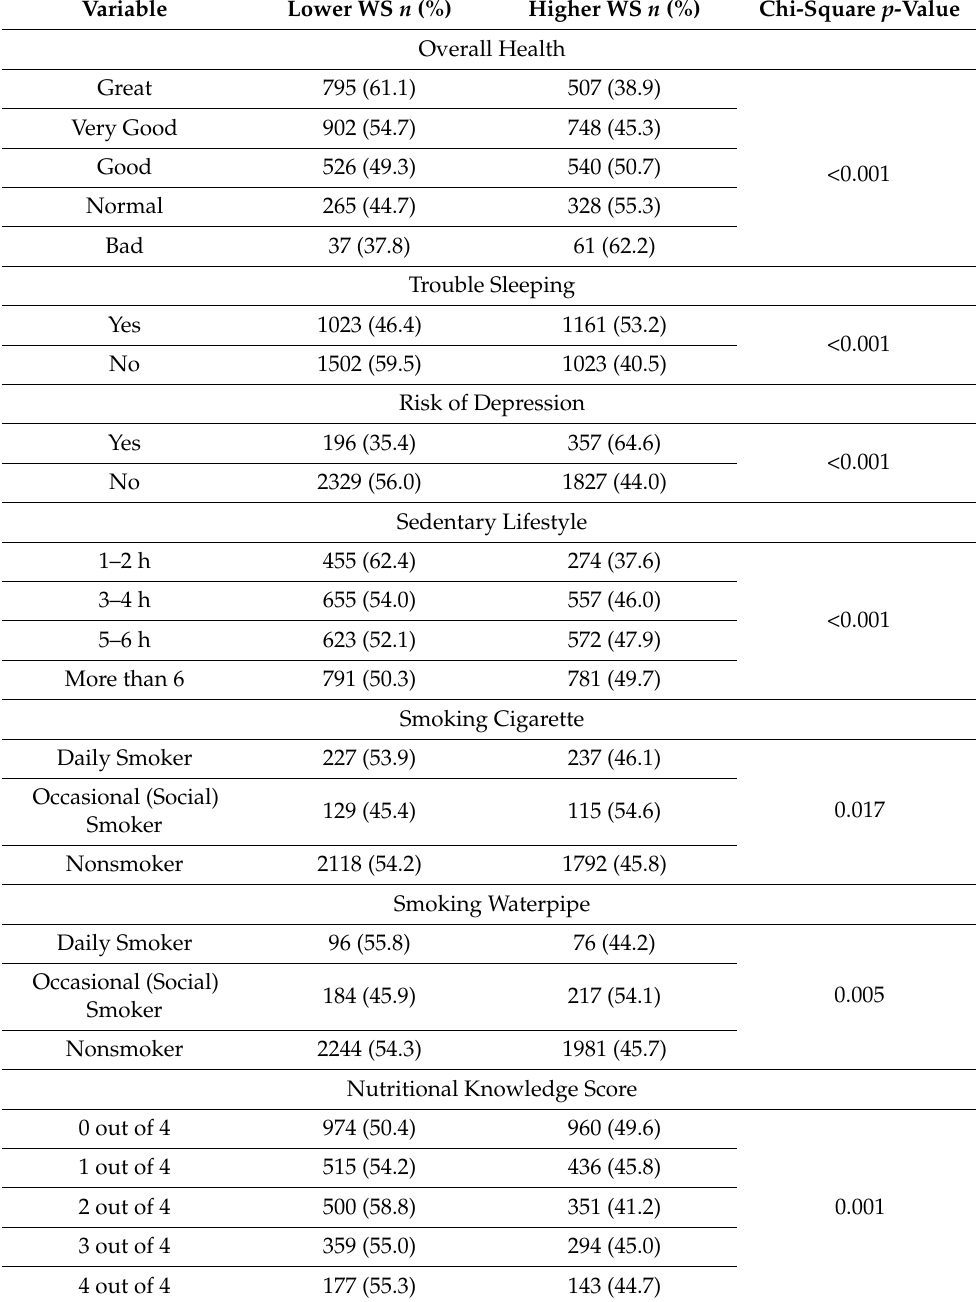
Table 3. Associations among WS, lifestyle, and basic nutritional knowledge ( n =